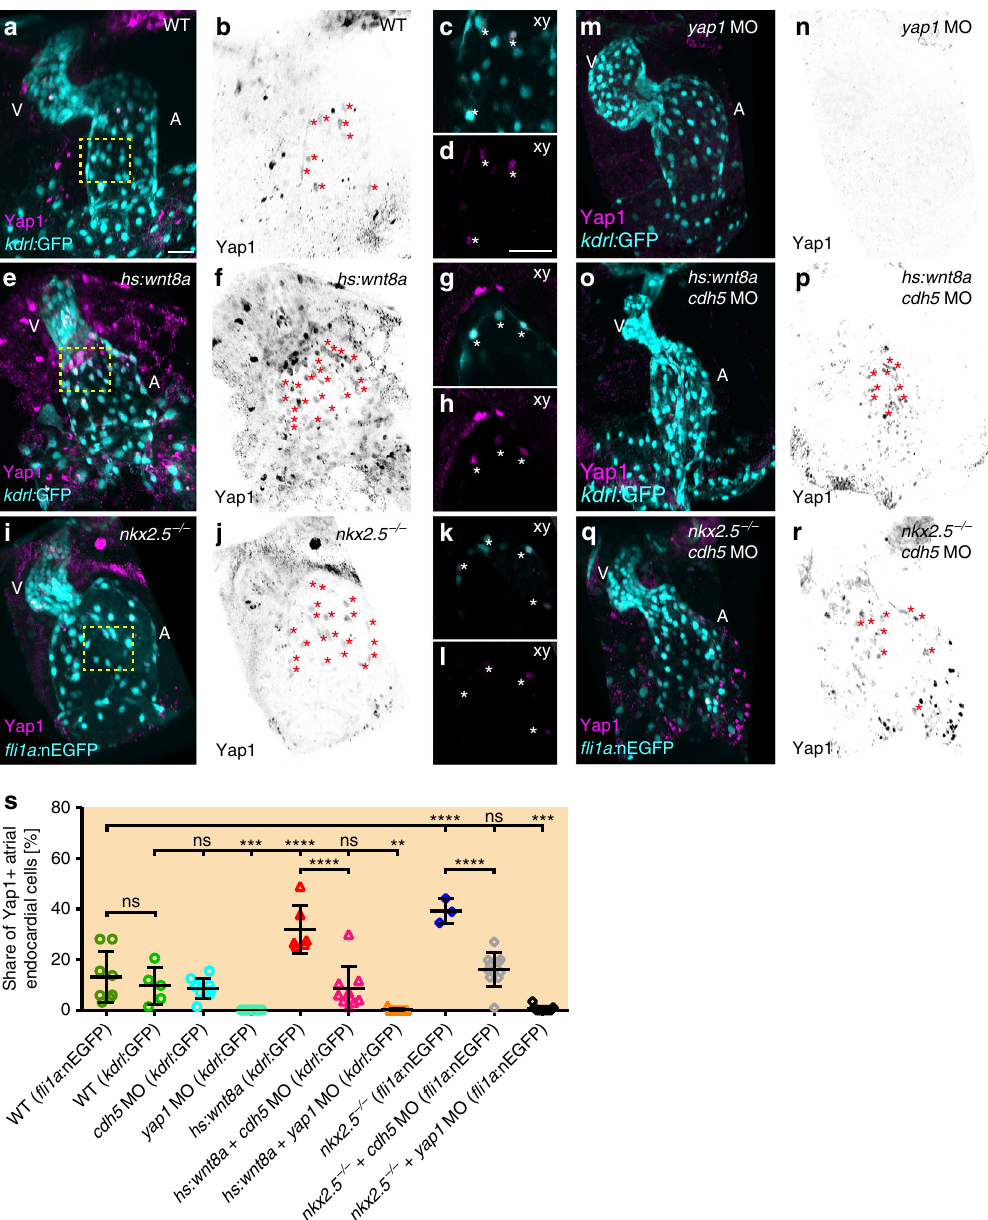
Fig. 6 Yap1 nuclear localization within the atrial endocardium increases upon chamber expansion. a , e , i , m , o , q Reconstructions of confocal z-stacks of zebra fi sh hearts at 52 hpf expressing the endocardial reporters Tg(kdrl:EGFP) s843 or Tg( fl i1a:nEGFP) y7 (cyan) and immunolabeling against zebra fi sh Yap1 (magenta). b , f , j , n , p , r Yap1 immunolabeling is inverted in black/white and endocardial cells which show co-localization with Yap1 labeling are marked with red asterisks. A atrium, V ventricle. Scale bars, 30 μ m. c , d , g , h , k , l Magni fi cations of single confocal XY section planes (yellow box in a , e , i ) are shown in c , g , k and, in d , h , l , only Yap1 immunolabeling is shown. Endocardial cells, labeled by Tg(kdrl:EGFP) s843 or Tg( fl i1a:nEGFP) y7 , that show co- localization with Yap1 are indicated with an asterisk. Scale bars, 30 μ m. s Quanti fi cations of the share of Yap1-positive endocardial cells relative to the total number of endocardial cells within the atrium. Upon Wnt8a overexpression ( n = 6 hearts) or loss of Nkx2.5 ( n = 3 hearts), the share of Yap1-positive endocardial cell numbers signi fi cantly increases within the developing atrial endocardium. Loss of Cadherin-5 (Cdh5) changes the share of Yap1-positive endocardial cells among Wnt8a overexpressing ( n = 9 hearts) or nkx2 . 5 vu179 mutant embryos ( n = 10 hearts) to WT levels. Knock down of Yap1 in all conditions leads to a massive reduction of Yap1-positive endocardial cells within the atrium ( yap1 MO: n = 11 hearts; yap1 MO + hs:Wnt8a : n = 9 hearts; yap1 MO + nkx2 . 5 vu179 mutant: n = 11 hearts). Mean values± SD are shown. One-way ANOVA was used to compare each condition with its WT control ( ns not signi fi cant, ** p < 0.01;*** p < 0.001; **** p < 0.0001)